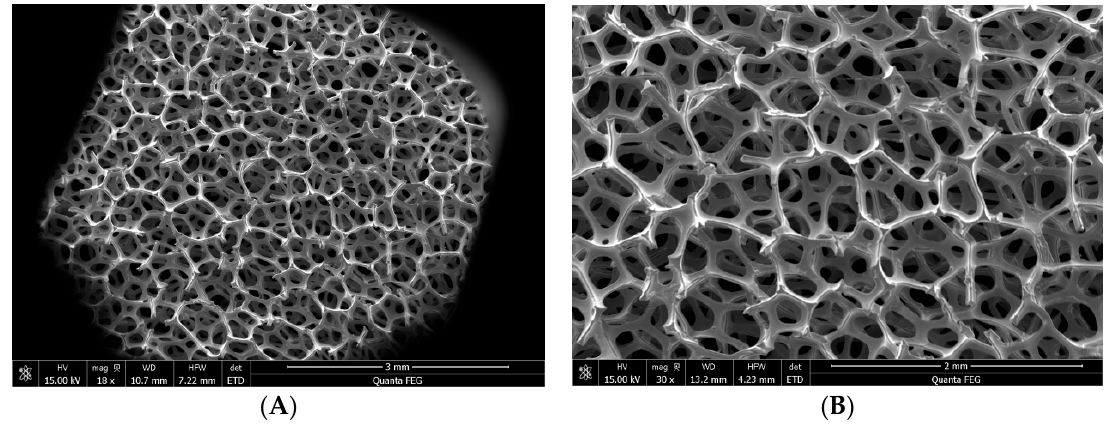
Figure 2. SEM images of nickel foam with different magnification ( A : 1800×; B : 3000×).